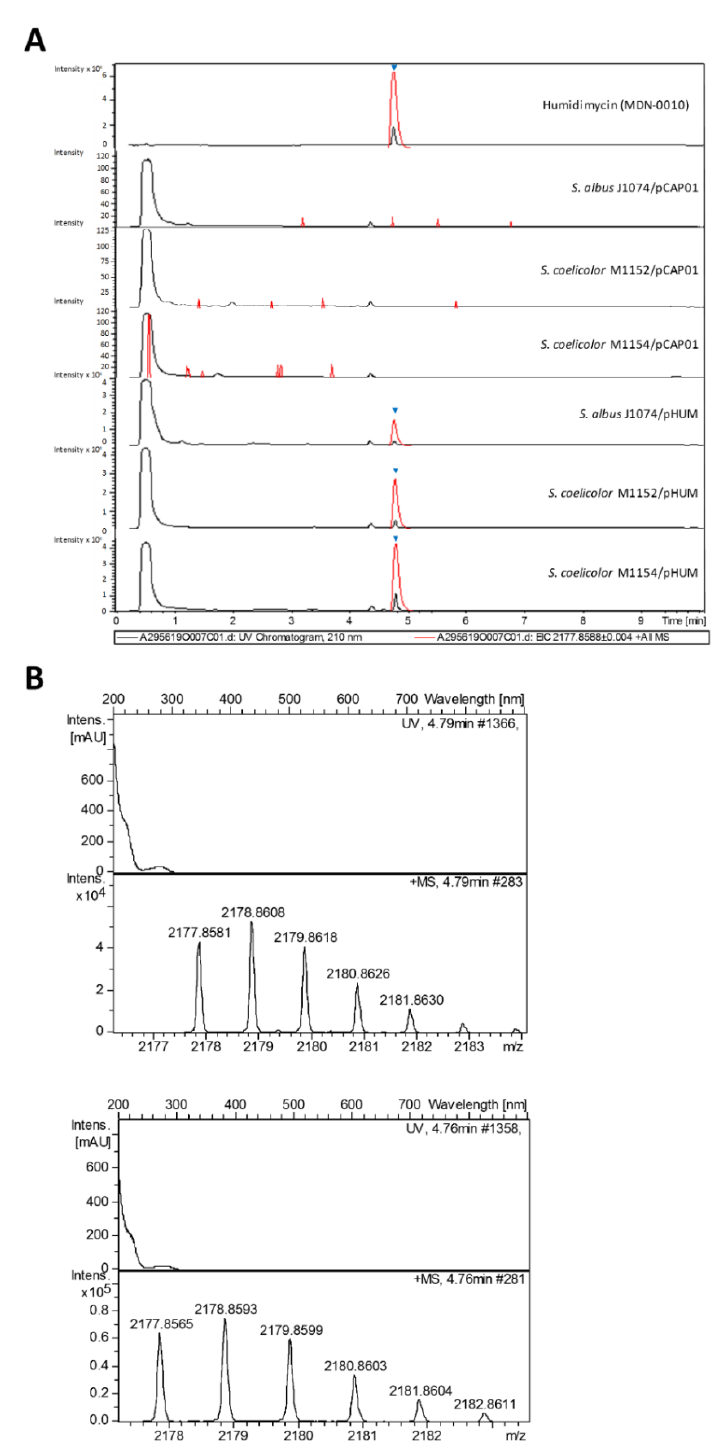
Figure 4. UV profiles at 210 nm (black) and extracted ion chromatograms (red) ( A ) at 2177.8588 ± 0.004 (C 98 H 133 N 22 O 27 S 4+ ) of humidimycin, the negative controls S. albus J1074/pCAP01, S. coelicolor M1152/pCAP01, and S. coelicolor M1154/pCAP01, and the transconjugants S. albus J1074/pHUM, S. coelicolor M1152/pHUM, and S. coelicolor M1154/pHUM. : humidimycin. ( B ) Experimental UV and mass spectra of M + H + humidimycin adduct (C 98 H 133 N 22 O 27 S 4+ ) from S. coelicolor M1154/pHUM (top), and from the original producer strain CA-100629 (bottom).